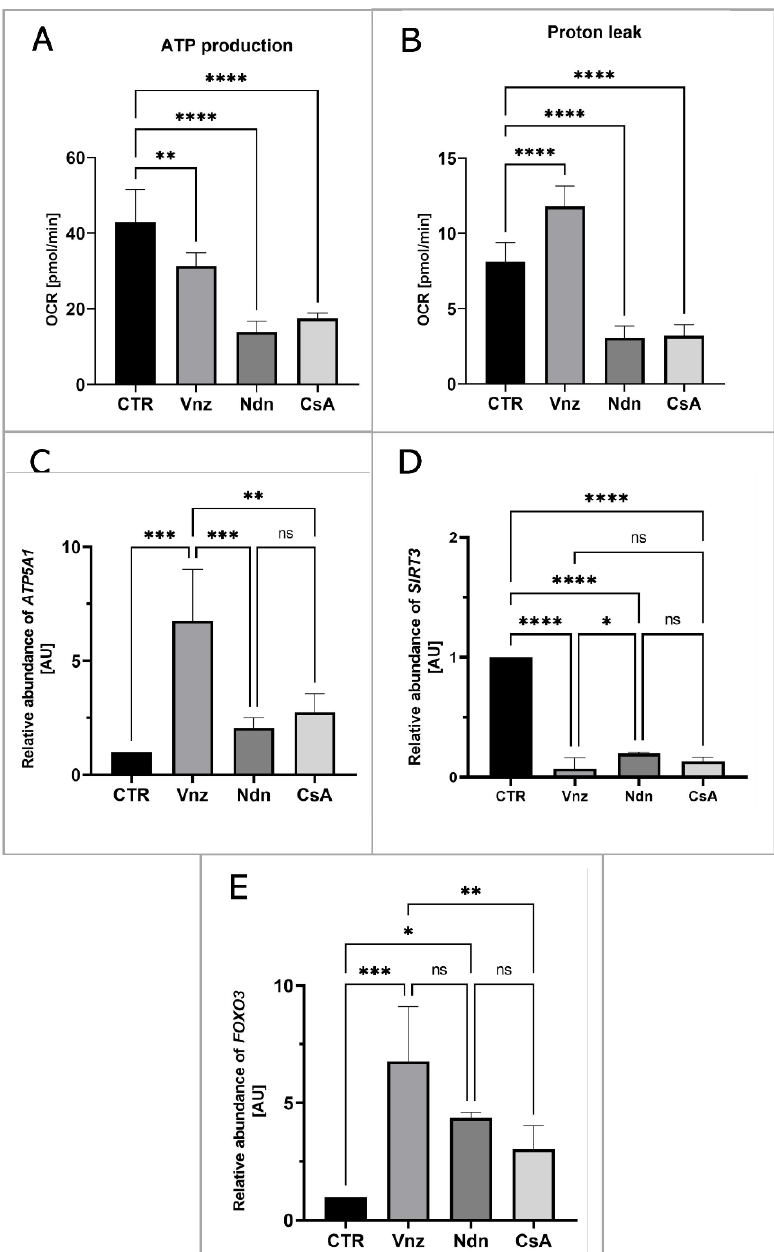
Figure 7. The live cell-based analysis of mitochondrial activity in porcine COCs subjected to the IVM procedure using a 3D culture model (alginate capsules) in control cultures (CTR) or in experimental cultures: in the presence of vinclozolin (Vnz), nandrolone (Ndn) or cyclosporin A (CsA). ( A ): ATP synthesis level analysis performed with the aid of Seahorse XF Cell Mito Stress Test; ( B ): proton leak analysis performed with the aid of Seahorse XF Cell Mito Stress Test; the results represent the mean value with n = 5 ± standard deviation (SD), and each “ n ” consisted of 12 COCs. Statistical analysis: homogeneity of variance—Brown–Forsythe test; normality of distribution—Bartlett’s test and one-way ANOVA followed by Dunnett’s post hoc test, ** p < 0.01, **** p < 0.0001 . ( C – E ): Quantitative profiles for expression of ATP5A1 , SIRT3 and FOXO3 genes, shown by RT-qPCR at the transcript level. The results represent the mean value with n = 5 ± standard deviation (SD), and each “ n ” consisted of 50 COCs. Statistical analysis: homogeneity of variance—Brown–Forsythe test; normality of distribution—Bartlett’s test and one-way ANOVA followed by Dunnett’s post hoc test, * p < 0.05, ** p < 0.01, *** p < 0.001, **** p < 0.0001; ns—nonsignificant.